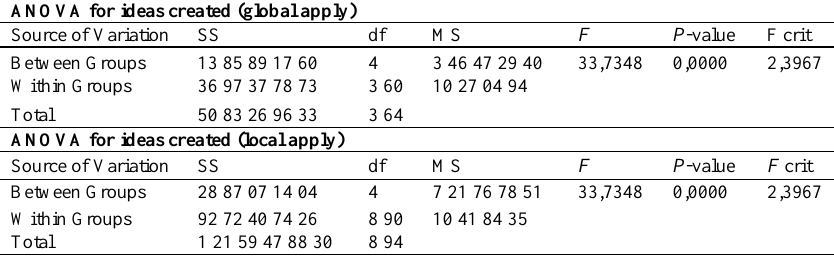
Table 3. ANOVA for ideas